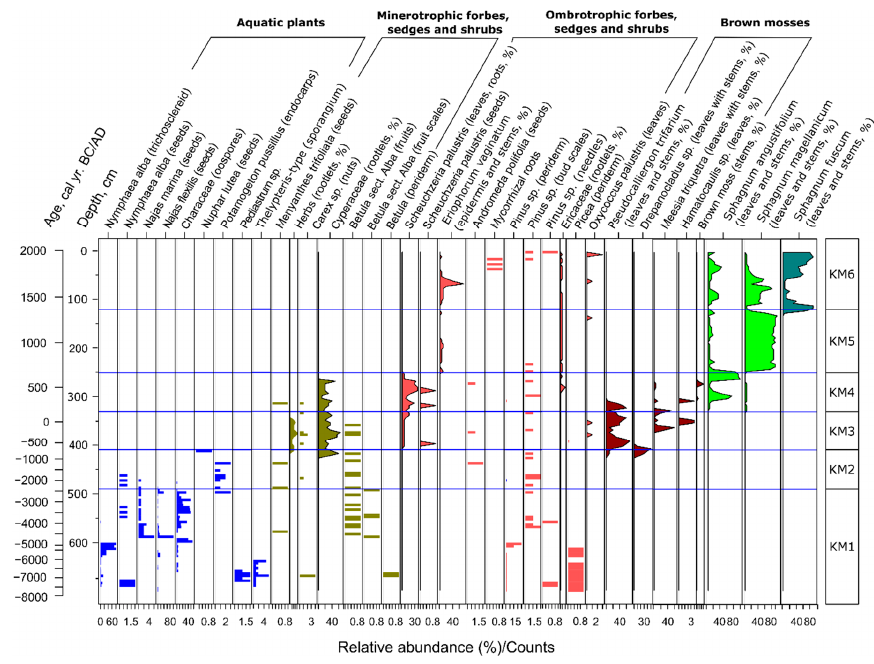
Figure 6. Plant macrofossil composition in the deposits of the Krivetskiy Mokh mire (polygons are percentages, %; bar plots—counts). Blue color—aquatic plants, olive color—minerotrophic forbes, sedges and shrubs, rose color—obmrotrophic forbes, sedges and shrubs, brown color—brown mosses, green color—lawn Sphagnum mosses; blue-green color—hummock mosses. KM1–KM6—the zones defined based on the main developmental stages of the mire. Diversity 2020 , 12 , x FOR PEER REVIEW